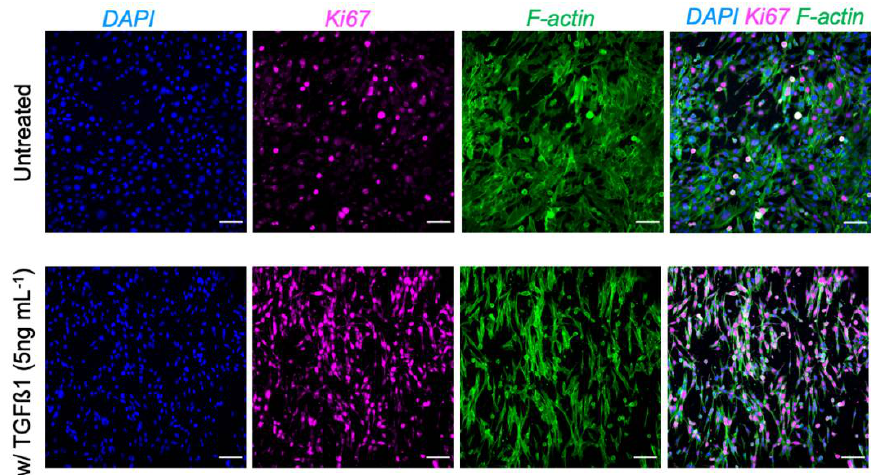
Figure 4. The IF analysis of mouse embryonic fibroblasts (MEF) on the BETA membrane without and with the treatment with TGF β 1 as a fibrotic agent. Ki67 , which is associated with cellular proliferation, is amplified after the induction of MEF with 5 ng mL −1 TGFβ1. Ki67 (magenta), F-actin cytoskeleton (green), nuclei (DAPI, blue). Scale bars are 100 µm.